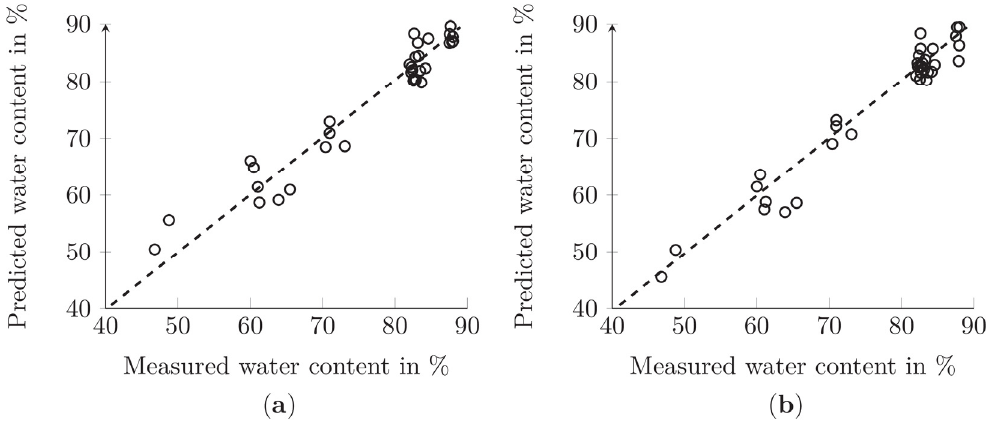
Figure 6. Measured versus predicted value of TWC for ( a ) absorbance and ( b ) reflectance data.